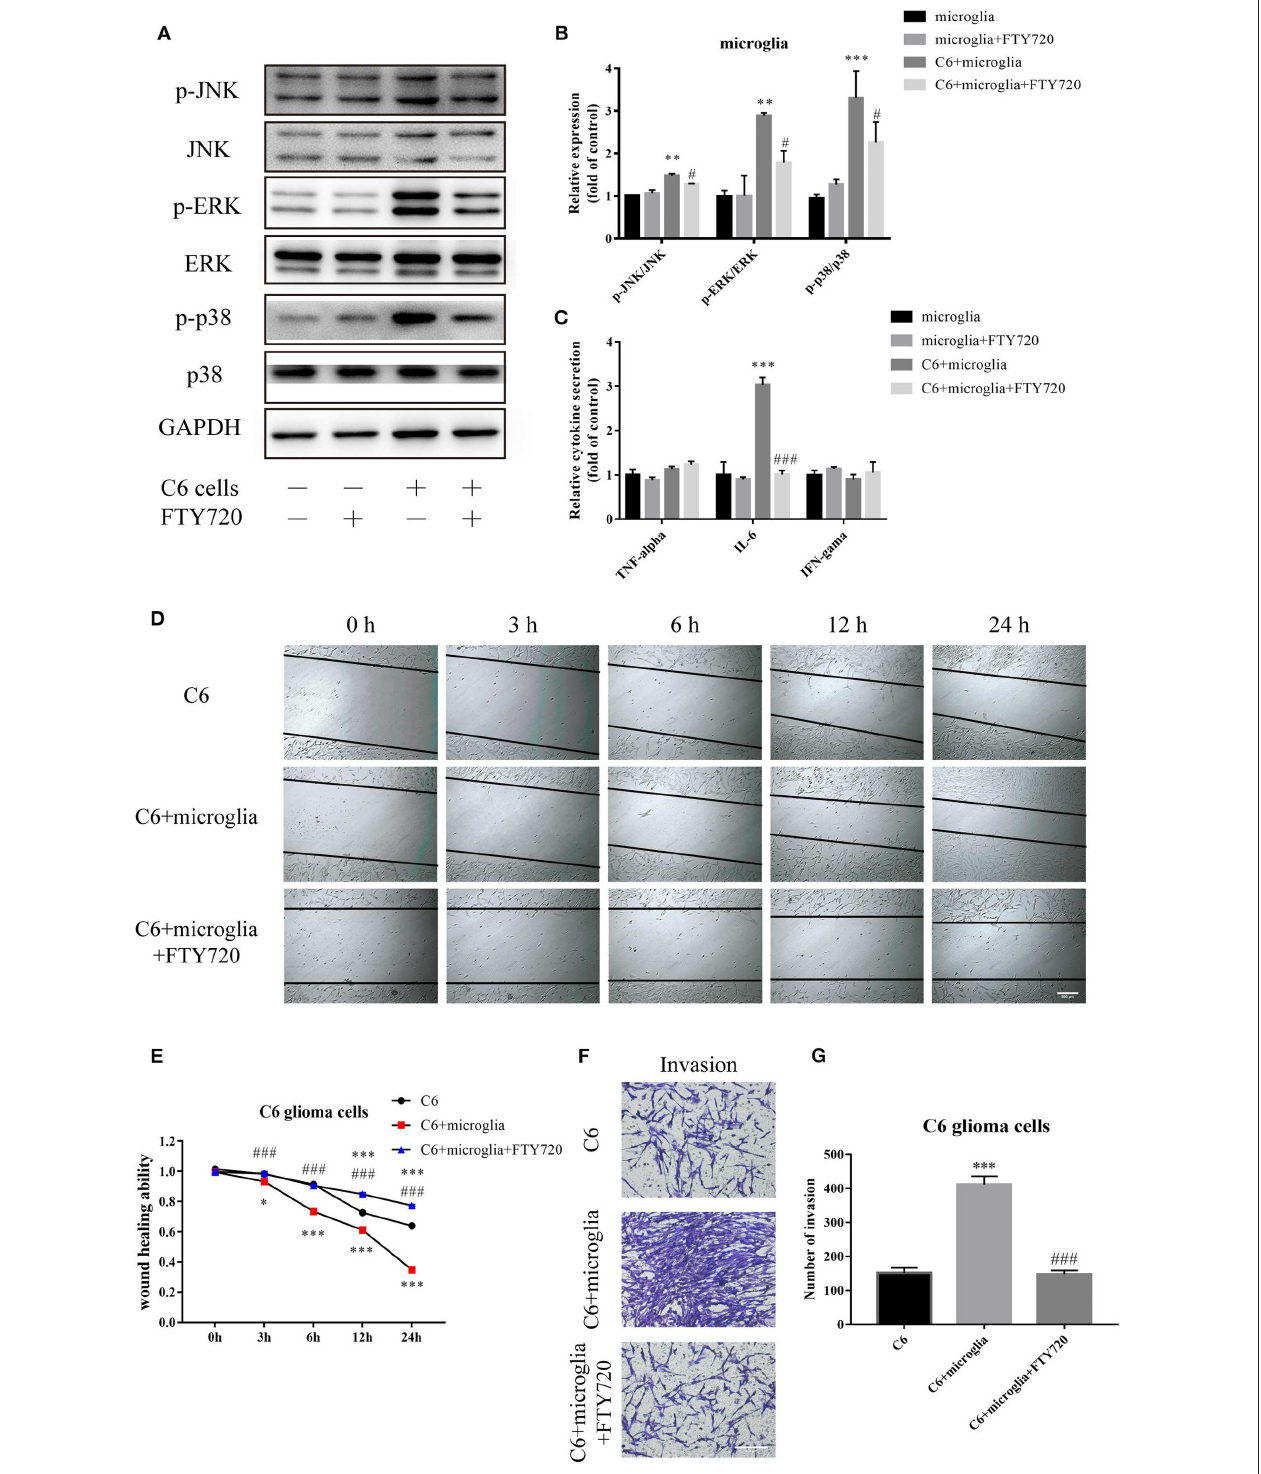
FIGURE 3 | FTY720 decreases microglial MAPK-mediated IL-6 secretion to suppress the migration and invasion of C6 cells. (A,B) Western blots analyze the phosphorylation of p38, JNK, and ERK1/2. (C) The concentration of TNF- α , IL-6, and IFN- γ in the cell culture supernatants. (D,E) Migration of C6 cells at different times (0, 3, 6, 12, and 24h) with/without FTY720 and representative analysis of C6 cell motility. (F,G) Representative images and analysis of C6 cell invasion under different treatment. Data are presented as mean ± SEMs, n = 4 for ELISA assays, ** p < 0.01 vs. microglia, # p < 0.05 vs. C6 + microglia; n = 3 for wound healing assays and Matrigel invasion assays, * p < 0.05, *** p < 0.001 vs. C6, ### p < 0.001 vs. C6 + microglia.